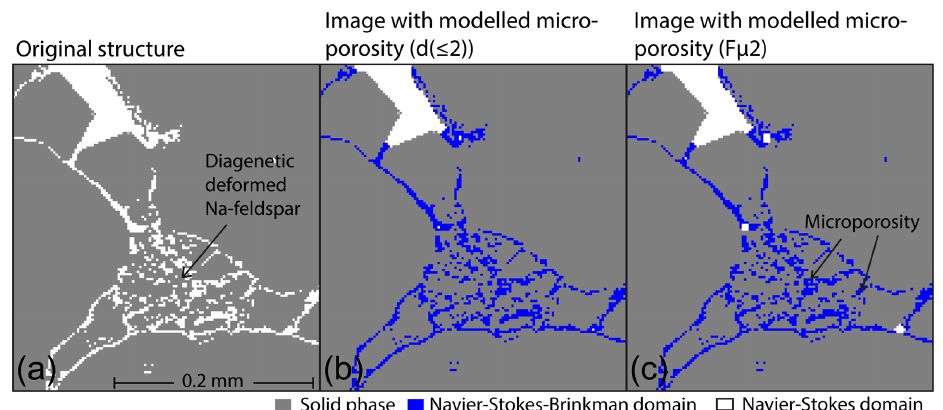
Figure 6. (a) Segmented µXCT image of the pore space of a mini plug. (b) Image with applied microporous domain using the Euclidian distance map approach. (c) Image with removed outer rim layer of larger pores.